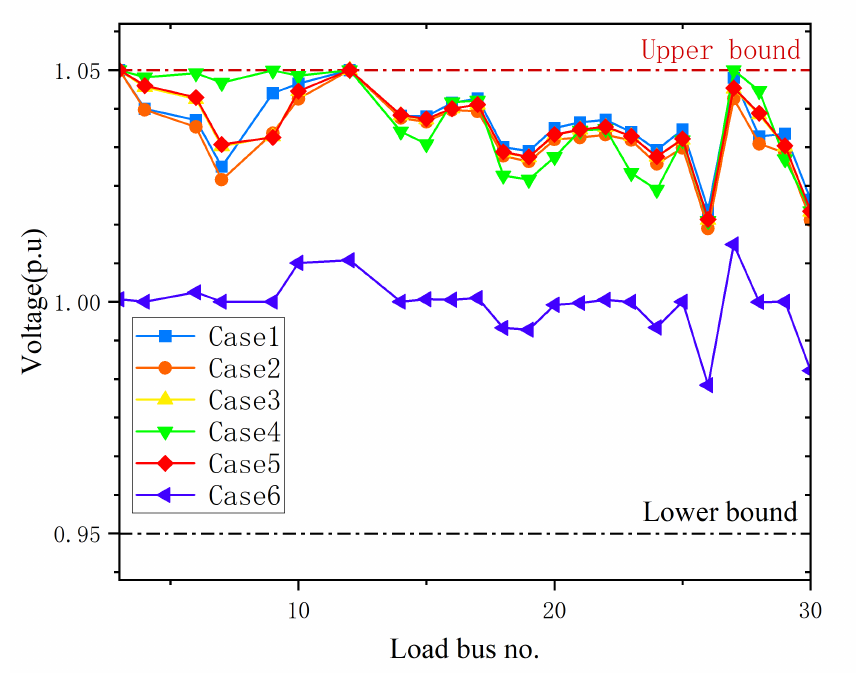
Figure 3. Security